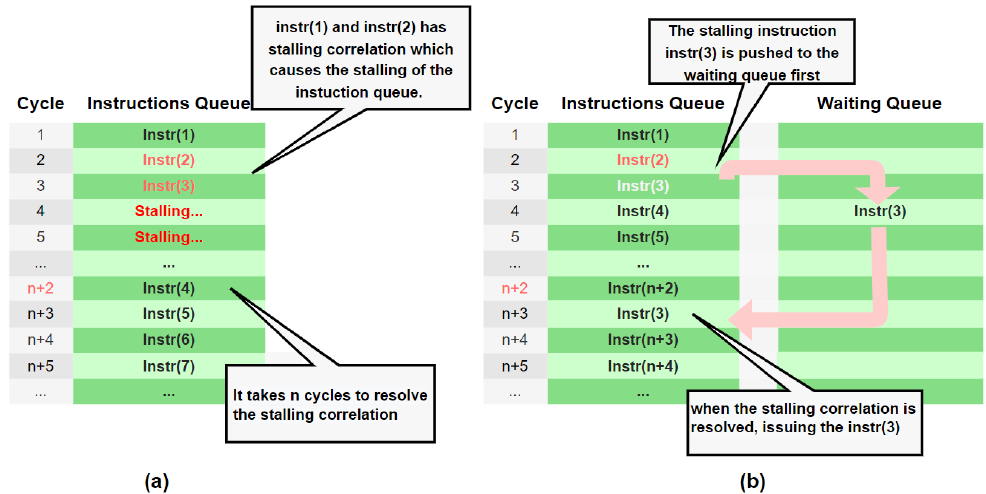
Figure 8. Theoretical analysis of the waiting queue. ( a ) Without waiting queue. ( b ) Optimized with waiting queue.